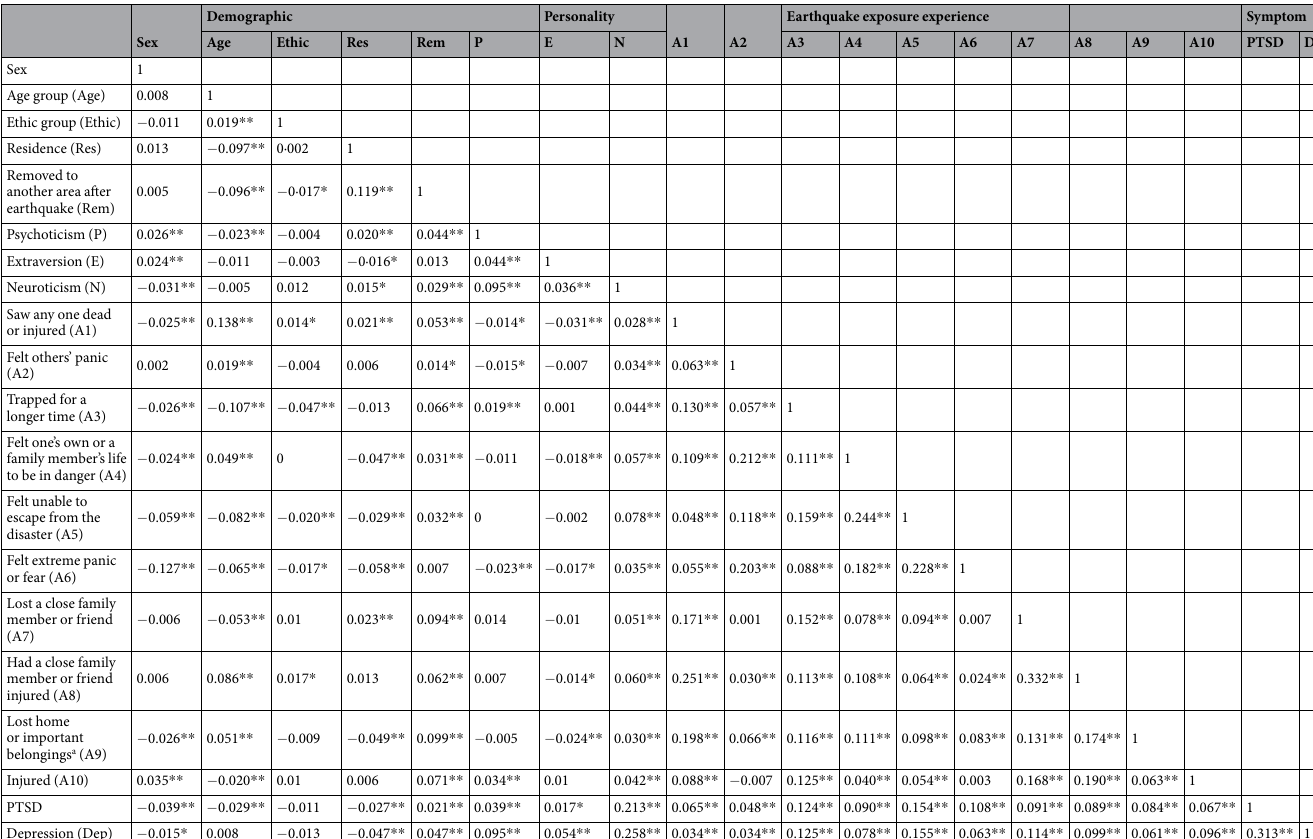
similar magnitude (31%) 24 , whereas other studies reported approximately 13% 20,45 . We attributed the much lower prevalence of PTSD and depression to the lower earthquake severity (5.9 magnitude) in latter studies. The preva- lence of comorbidity was high, which was in accordance with previous studies. The neuroticism trait was a risk factor of only PTSD symptoms, and stability was its protective factor after con- trolling for other confounders. In the presence of neuroticism, children were 8 times more likely to suffer PTSD symptoms than those with a stability trait. Notably, in the presence of high neuroticism, the risk for children to suffer a co-occurrence of PTSD and depression symptoms was 40 times more than for children with the stability trait. These results further confirmed the findings of previous studies that neuroticism has played an important role in predicting the probability of PTSD due to its negative mood feature 46,47 . Moreover, the overlapping aspect of neuroticism and arousal symptoms might contribute to its effect on elevating the risk of PTSD 48 . Based on the results of this study, we recommend that future studies evaluate the neurotic personality as an essential risk factor for PTSD among children. Extraversion was not associated with PTSD among children, but it was a protective factor of the comorbidity of PTSD and depression symptoms. Unlike neuroticism, extraversion was less consistent with PTSD in previous research. Some researchers revealed that extraversion had no relationship with PTSD 9,49 , whereas a negative rela- tionship was reported in other studies 13,50 . According to the results of this study, whether the impact of comorbid depression is controlled may explain the difference, which implies the critical role of comorbid depression in detecting the impact of extraversion on PTSD. Psychoticism, reported as a risk factor in only a few earlier stud- sion symptoms. Accordingly, future studies should consider the impact of comorbid depression. In this study, subjective exposure experiences—feeling unable to escape from the disaster, experiencing extreme panic or fear and being trapped for a longer time—were identified as risk factors for PTSD, which was similar to the findings of other researchers 53,54 . Another study showed that children who experienced extreme panic or fear had a 9-timehigher risk for PTSD symptoms than children without this experience 22 , whereas our result only showed a two-time higher risk. We believe that controlling the impact of personality traits in our study could explain the lowered risk. Inability to escape a traumatic stressor—that is, the uncontrollability of a stressor—has been found to be a crucial risk factor for PTSD in trauma survivors 55 , and a perceived threat is very likely to be linked to the onset of PTSD. In addition, research conducted on earthquake survivors has shown that fear or a sense of threat during earthquake exposure is a strong predictor of PTSD symptoms, explaining a greater